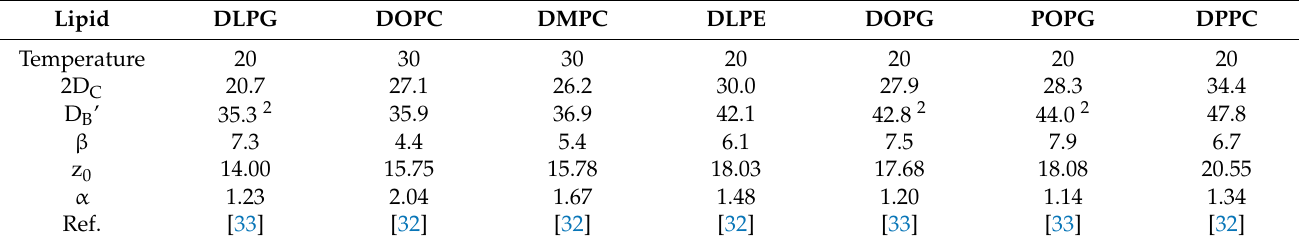
Table 1. Structural model parameters derived for several lipid types 1